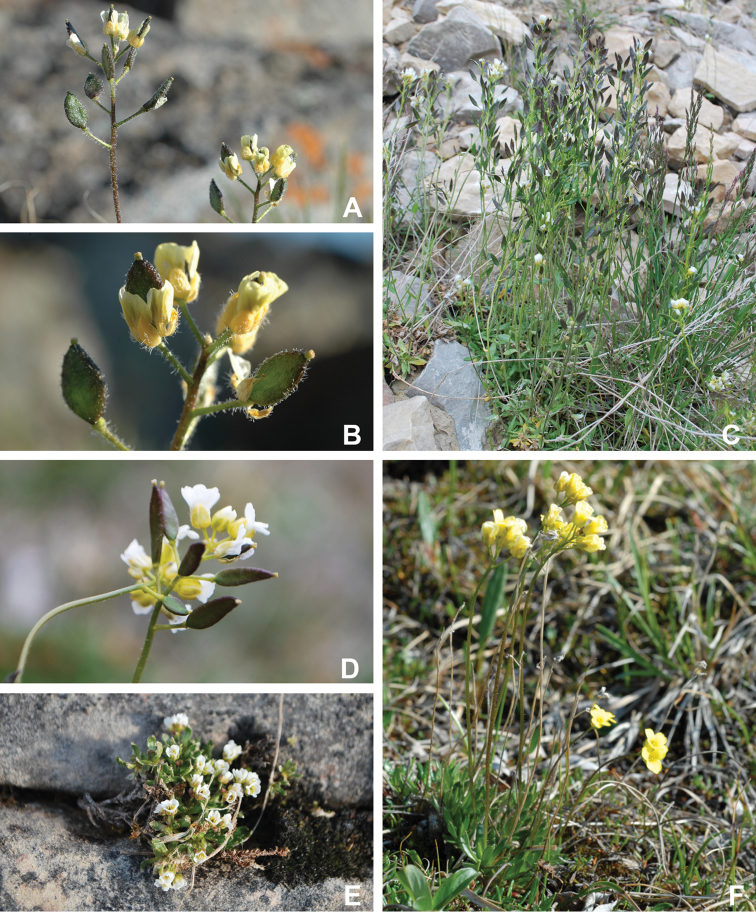
ADraba
corymbosa habit, Gillespie et al. 9994BDraba
corymbosa developing fruits, Gillespie et al. 9994CDraba
glabella habit DDraba
glabella inflorescence and fruits EDraba
lactea habit FDraba
pilosa habit, Gillespie et al. 9679. Photos A, B by R.D. Bull C–E by B.A. Bennett and F by L.J. Gillespie.